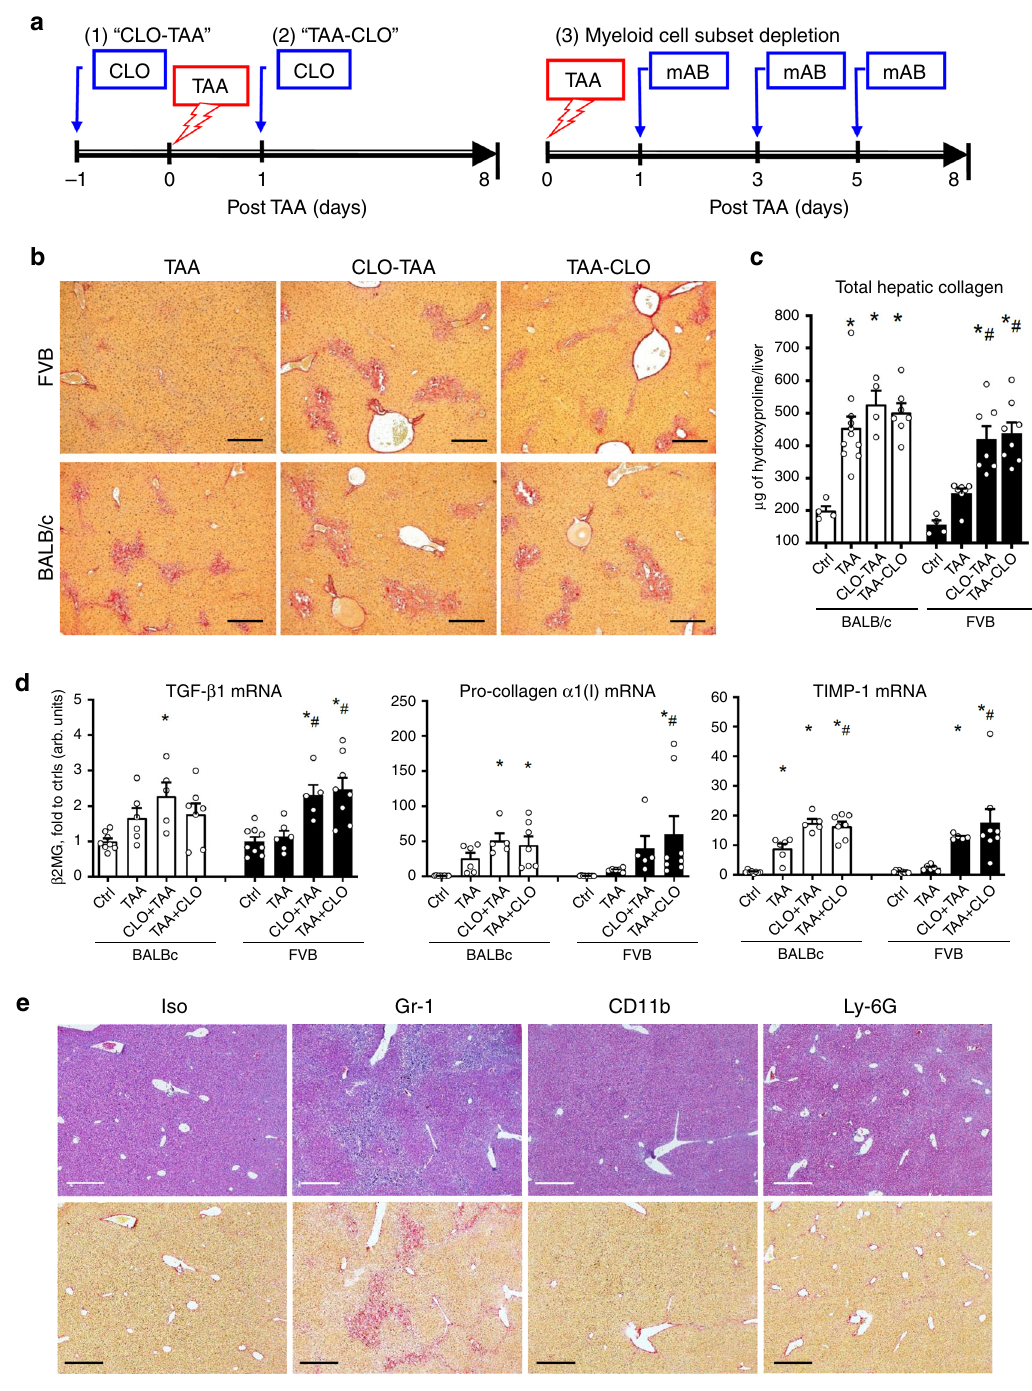
assay, respectively ( p < 0.05, Fig. 5d, e). Areas of collagen deposition in livers of mito-DAMP-treated mice overlapped with a massive increase in immunopositivity for α -SMA, an HSC activation marker. Moreover, pro- fi brogenic gene transcript levels of TGF β 1, pro-collagen α 1(I), and TIMP-1 in livers of mito- DAMP-treated mice remained elevated 3 – 4-folds at day 8 post injury (Fig. 5f). In order to validate these fi ndings in a second, mechanistically different model of steatohepatitis, we injected mice primed with short-term methionine- and choline-de fi cient diet (MCD) feeding (2 weeks) with a single dose of puri fi ed mito- DAMPs (9.5 μ g/mouse, i.p.) and examined the livers 24 h later; in situ immunostaining for α -SMA revealed massive activation